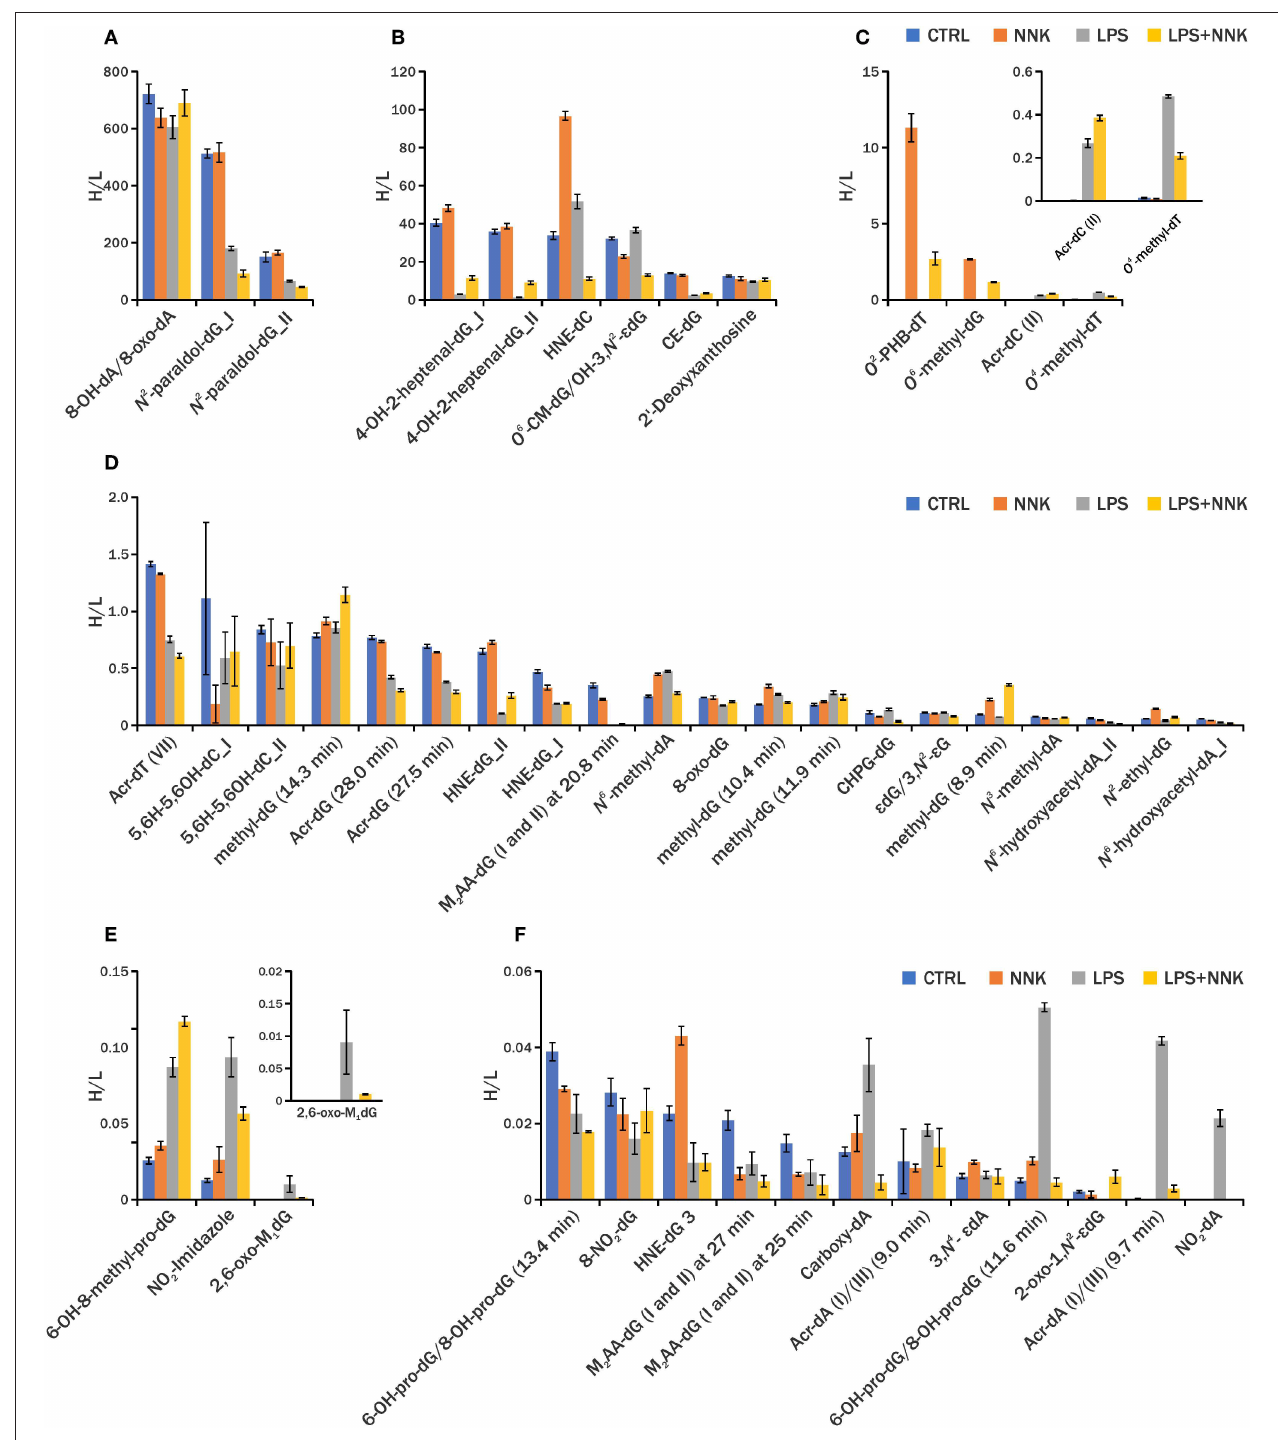
FIGURE 3 | Relative quantification of DNA adducts among different DNA samples (A–F) . Blue, orange, gray, and yellow histograms are levels of DNA adducts detected in lung sample from controls and animals treated with NNK, LPS and LPS + NNK, respectively. Reported here is the AUC/ [ 15 N 5 ]- N 2 -ethyl-dG H/L for each DNA adduct in different groups of samples ( n = 3). Retention times are reported for the DNA adducts that were detected as multiple isomers.